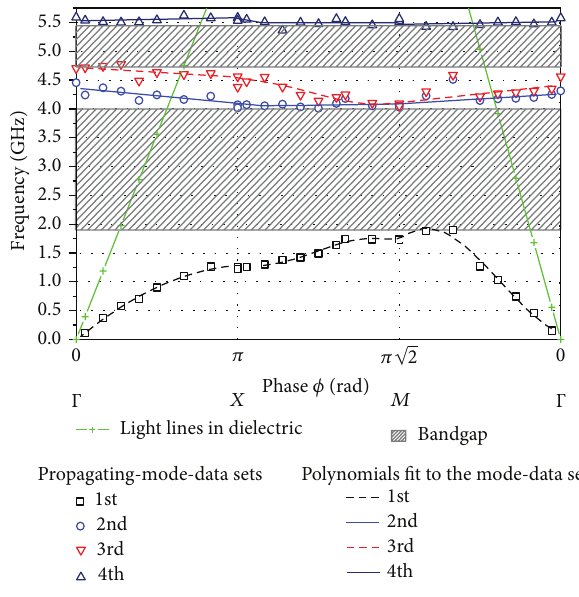
Figure 2: Dispersion diagram of the planar EBG structure shown in Figure 1 and light lines in dielectric. Four sets of data points showing the first four propagating modes are extracted numerically using HFSS. The curves fitted to these sets of data are plotted in the diagram. The design parameters of the EBG are: 𝑃 𝑊 = 1.6mm, 𝑀 𝑊 = 0.02 mm, 𝑀 𝐿 = 1.6mm, 𝑀 𝐺 = 0.02 mm, ℎ = 114.3 𝜇 m, 𝜀 𝑟 = 140, and tan 𝛿 =